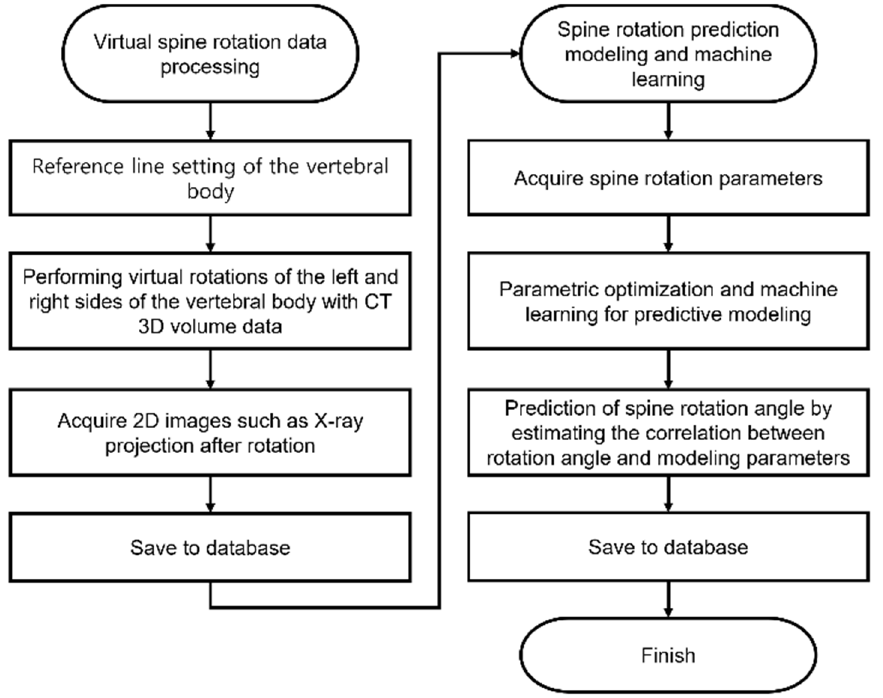
Figure 1. Machine Learning Workflow.